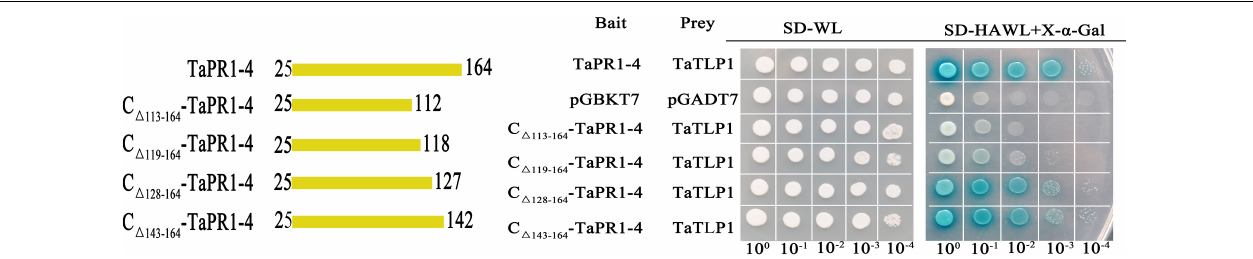
FIGURE 2 | The α IV helix of TaPR1-4 is indispensable for the interaction with TaTLP1. Truncated TaPR1-4 constructs were generated, including C-terminal deletion of residues 113–164 (C (cid:49) 113 − 164 -TaPR1-4), deletion of residues 119–164 (C (cid:49) 119 − 164 -TaPR1-4), deletion of residues 128–164 (C (cid:49) 128 − 164 -TaPR1-4), and deletion of residues 143–164 (C (cid:49) 143 − 164 -TaPR1-4) as bait, with TaTLP1 as prey. Each of the constructs was co-transformed with TaTLP1 into yeast. TaPR1-4 (bait) and TaTLP1 (prey) are the positive controls; pGADT7 and pGBKT7 are used as the negative controls. All transformants can grow on synthetic dropout medium without leucine and tryptophan (SD-WL) medium. Yeast colonies that were able to grow on a selective medium (SD medium without leucine, tryptophan, histidine, and adenine supplemented with X- α -Gal and Aureobasidin A [SD-HAWL]) and displayed blue coloration confirmed the protein–protein interaction.